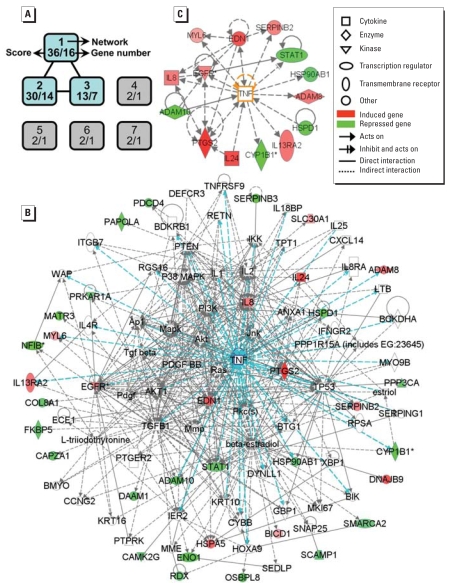
Pathway analysis of genes differentially expressed by microarray in Cd-treated NPrEC cells. When the 48 genes (Figure 3, Table 1) were input into IPA, it mapped them to three networks with high relevancy scores and four networks of low scores (A). The three high score networks were merged into a single network with 35 genes (B), with TNF as the largest node connected to 14 genes (C). The score indicates the degree of relevance of a network to the molecules in the input data set, which takes into account the number of network-eligible genes and the size of the network. Additional information is available at the IPA website (Ingenuity Systems 2008). The brighter the color of the gene, the higher the fold changes.*Multiple identifiers in the array data set file map to a single gene.